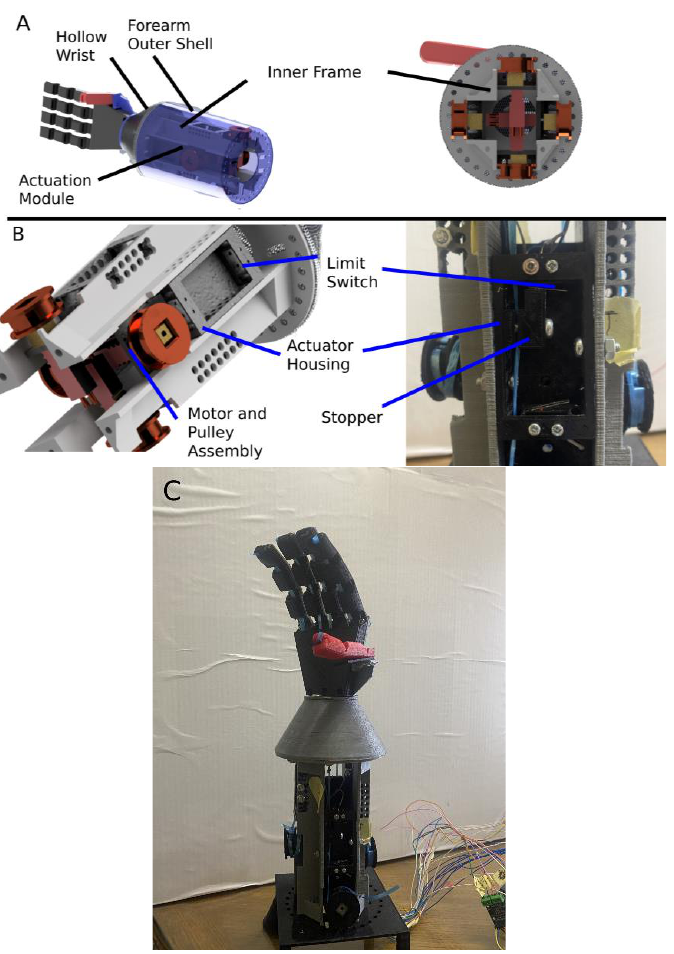
Figure 3. ( A ) Illustration detailing the components of the assembly with an isometric view ( left ) and a bottom view ( right ). ( B ) Illustration detailing the elements of the actuation module. ( C ) Image showing the entire assembly of the final prosthetic.